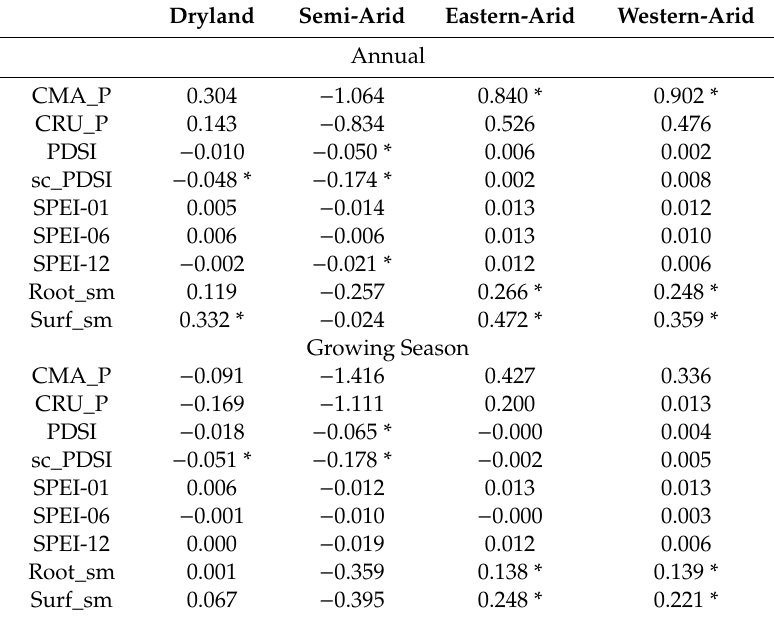
Table 2. Linear Trends of nine dryness indicators: precipitation including CMA_P and CRU_P